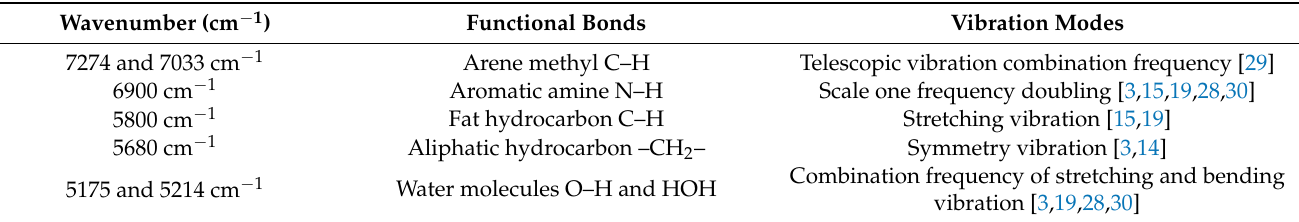
Table 1. Functional bonds and vibration modes in the NIRR module.